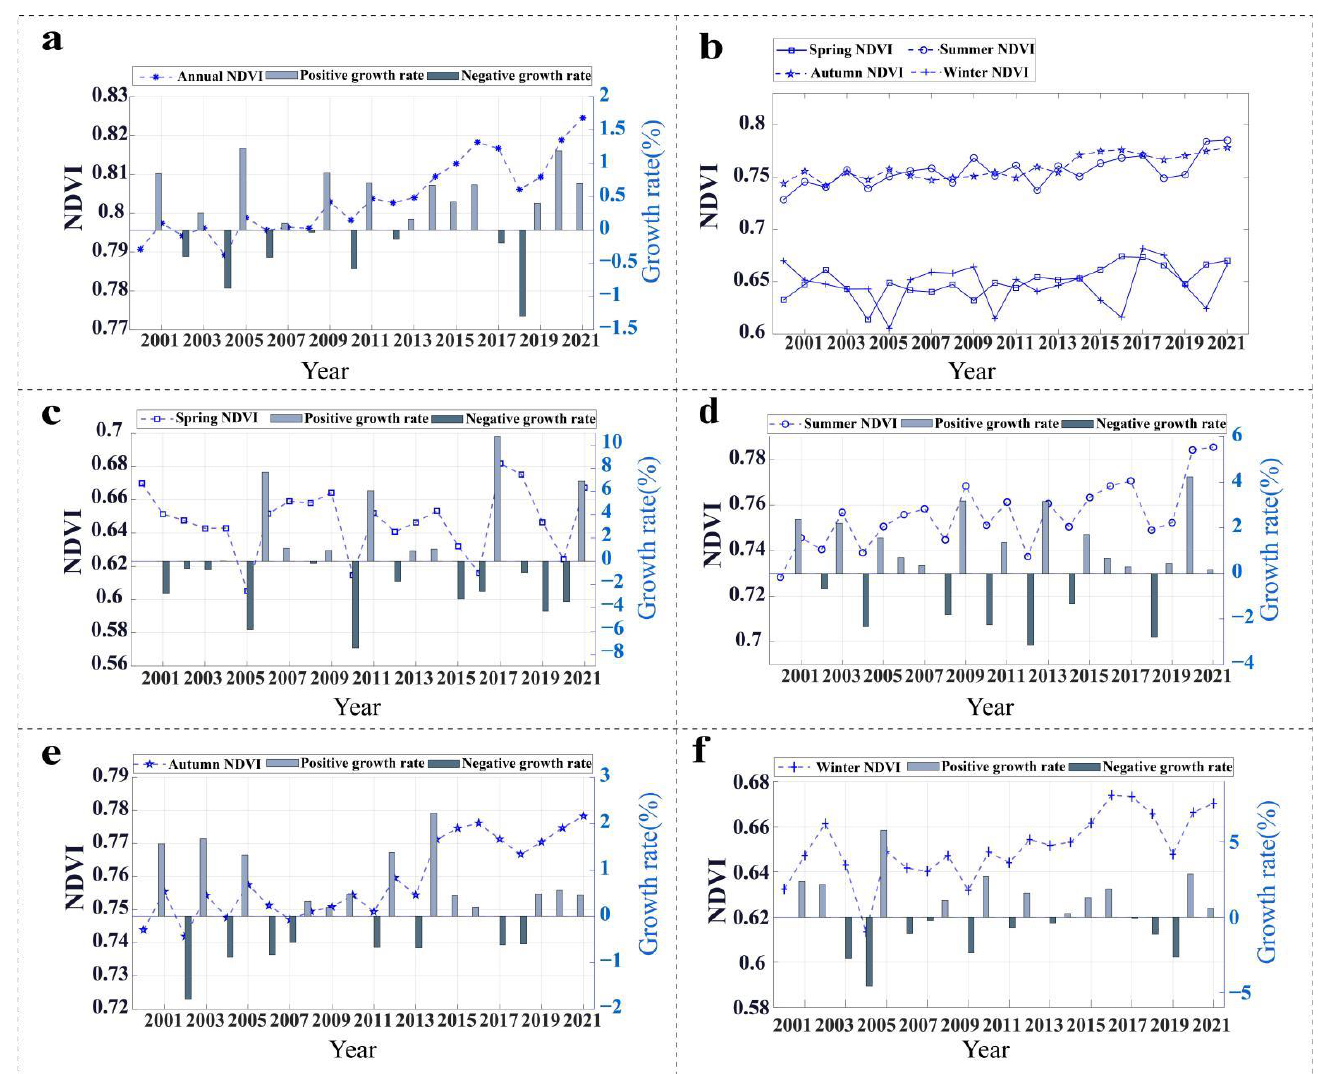
Figure 3. Temporal change of the NDVI from 2000 to 2021. ( a ) Average annual; ( b ) seasonal; ( c ) spring; ( d ) summer; ( e ) autumn; ( f ) winter.